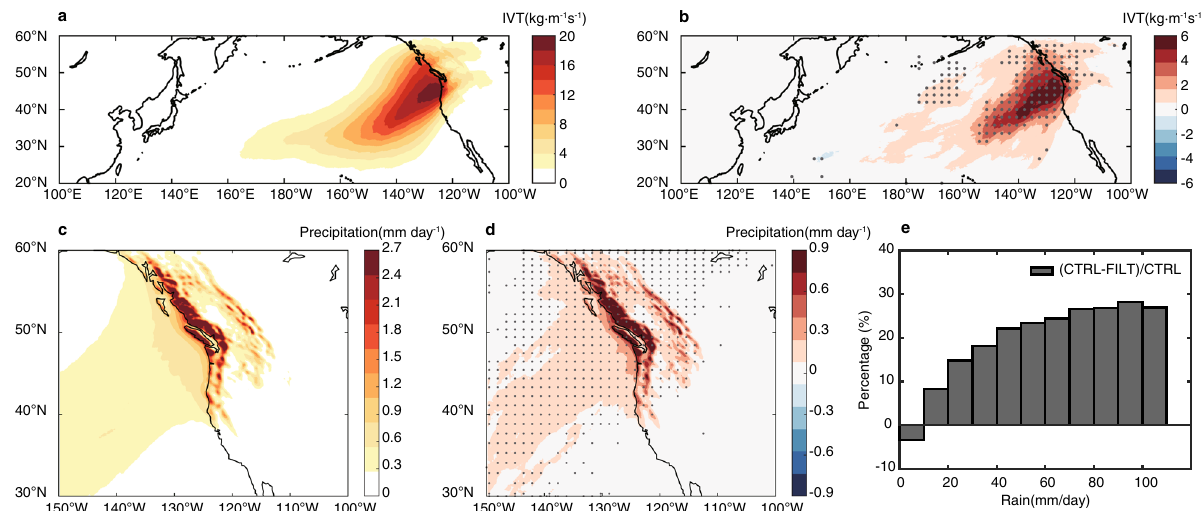
Fig. 2 Response of landfalling atmospheric rivers (ARs) and heavy precipitation to mesoscale sea surface temperatures in the seasonal ensemble experiment. Landfalling AR integrated water vapor transport (IVT) summed over the heavy precipitation days and then divided by the total number of days (150 × 65) in seasonal-ensemble control (SE CTRL) ( a ) and the corresponding difference between SE CTRL and fi ltered (FILT) ( b ). c , d same as a and b , but for precipitation. Probability density function (PDF) of relative difference of precipitation concurrent with landfalling ARs between SE CTRL and FILT in reference to SE CTRL (the red curve in Fig. 1) ( e ). Heavy precipitation events are de fi ned as area-averaged (magenta box in Fig. 1c) daily precipitation events exceeding the 75th percentile of the value. The difference above 95% con fi dence level based on a two-sided Student ’ s t test is shaded by gray dots.